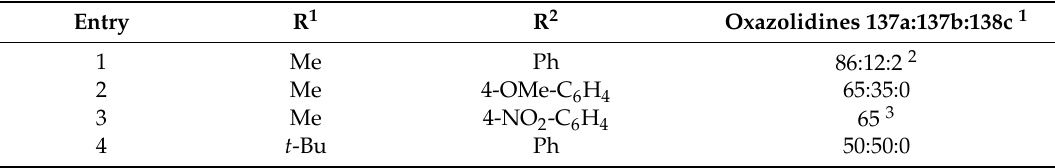
Table 19. Cycloaddition of azomethine ylide 136 to aldehydes 2 (Scheme 34).